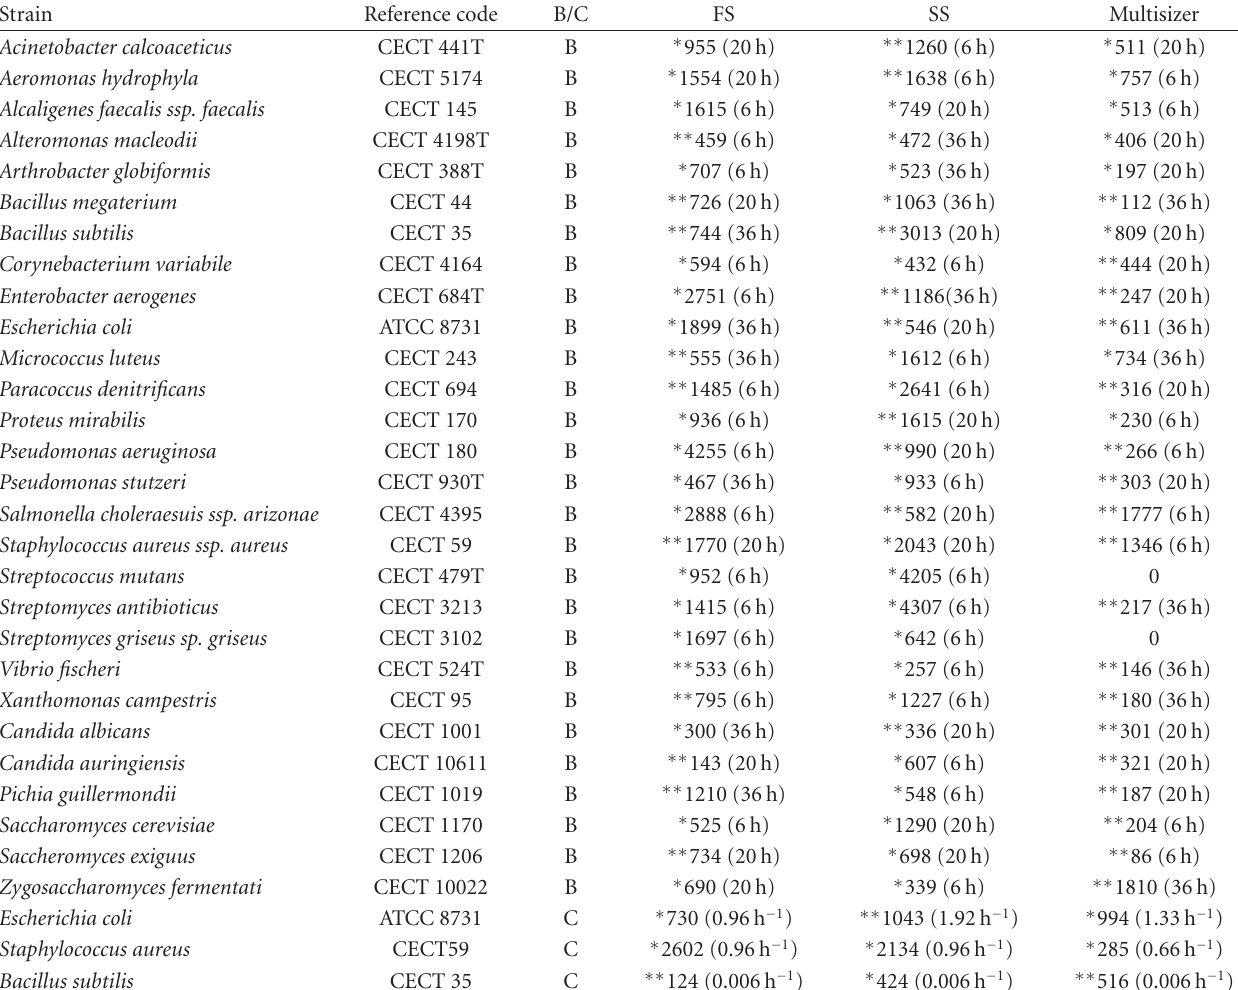
Table 1: Strains used in the present study and the highest (or maximal) N crit values